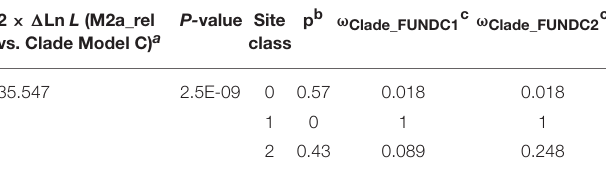
TABLE 2 | Likelihood ratio tests for divergence in selective pressure among FUNDC1 and FUNDC2 in vertebrates by using clade model